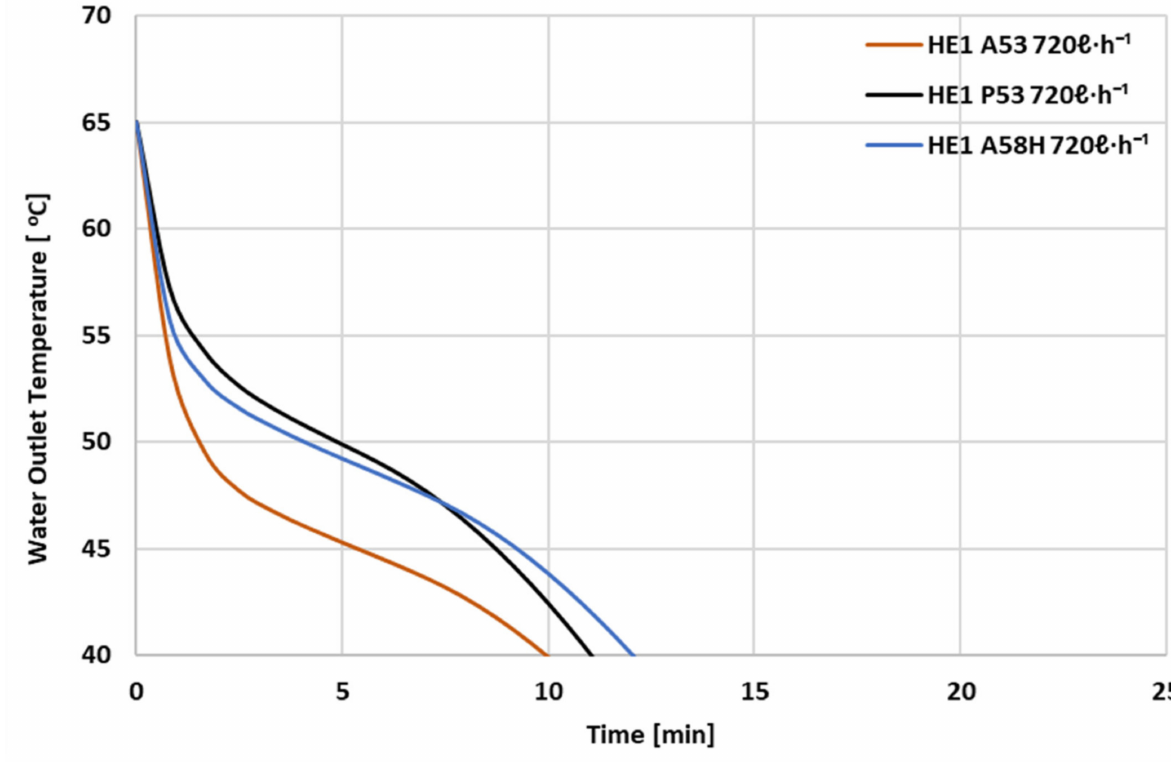
Figure 13. Water outlet temperature versus time for all PCMs studied, for HE1.